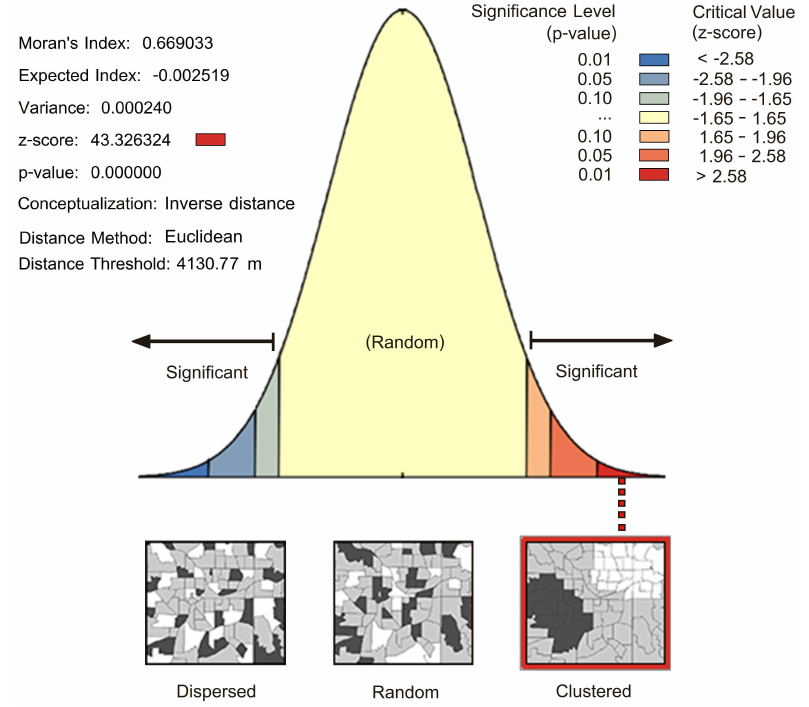
Figure 3. The spatial autocorrelation report from the Moran’s I technique of the ArcMap 10.2.2 software. The figure indicates that there is a high spatial autocorrelation in this study.